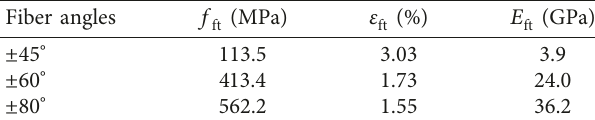
Table 2: Properties of FRP rings under hoop